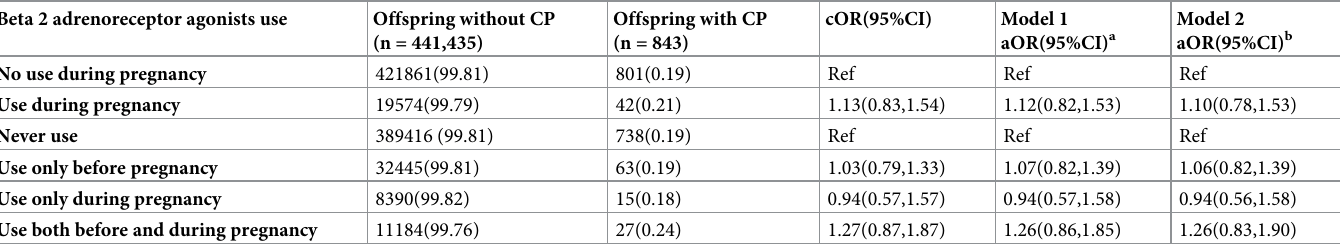
Table 2. Association between maternal β 2AAs usage and cerebral palsy in